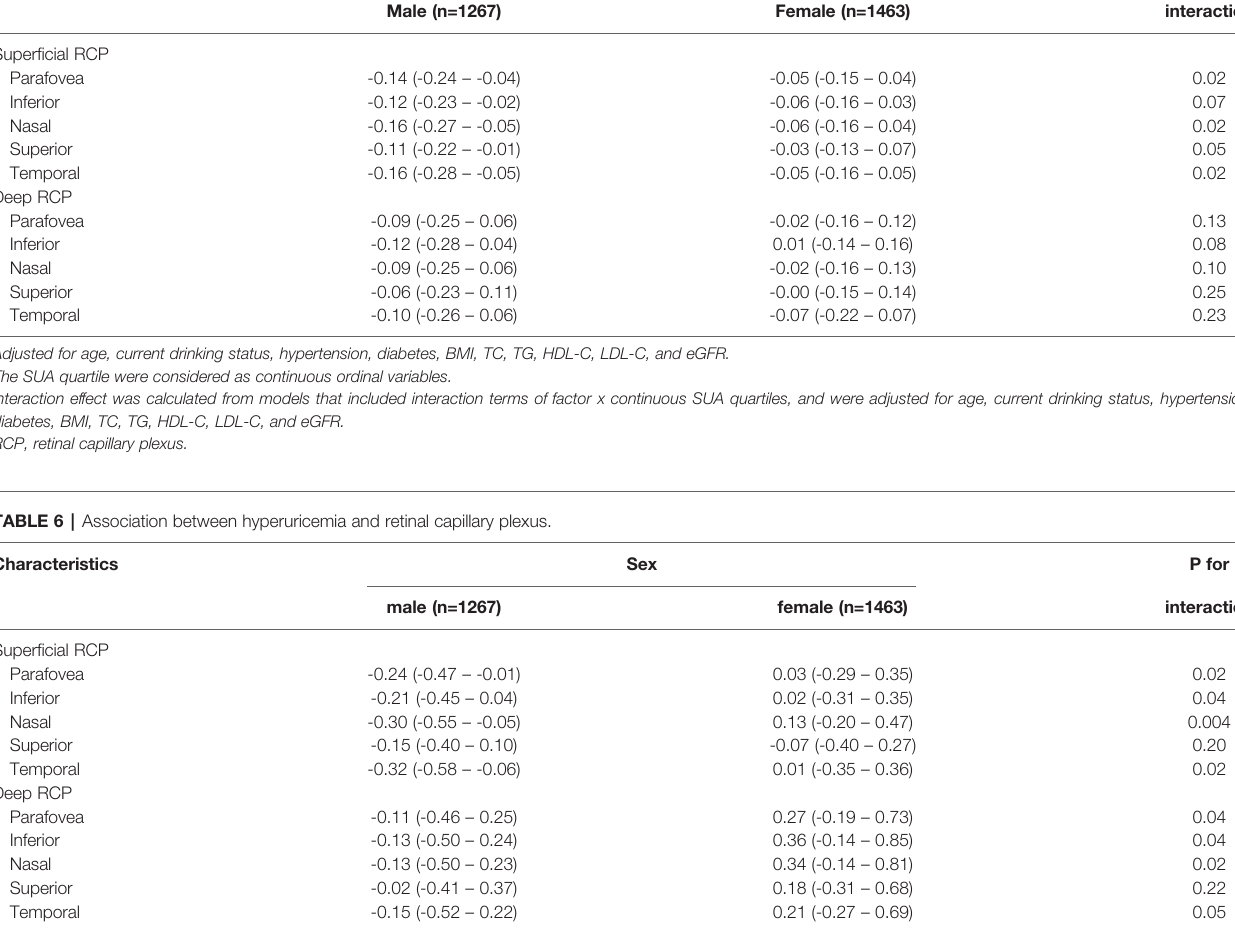
TABLE 5 | Impact of serum uric acid on retinal capillary plexus according to sex. Characteristics